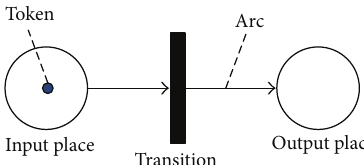
𝑚 : 𝑃 → 𝑁 and is a marking whose 𝑖 th component 𝑖 represents the number of tokens in the 𝑖 th place. An initial marking is denoted by 𝑚 0 . The tokens are pictured by dots.